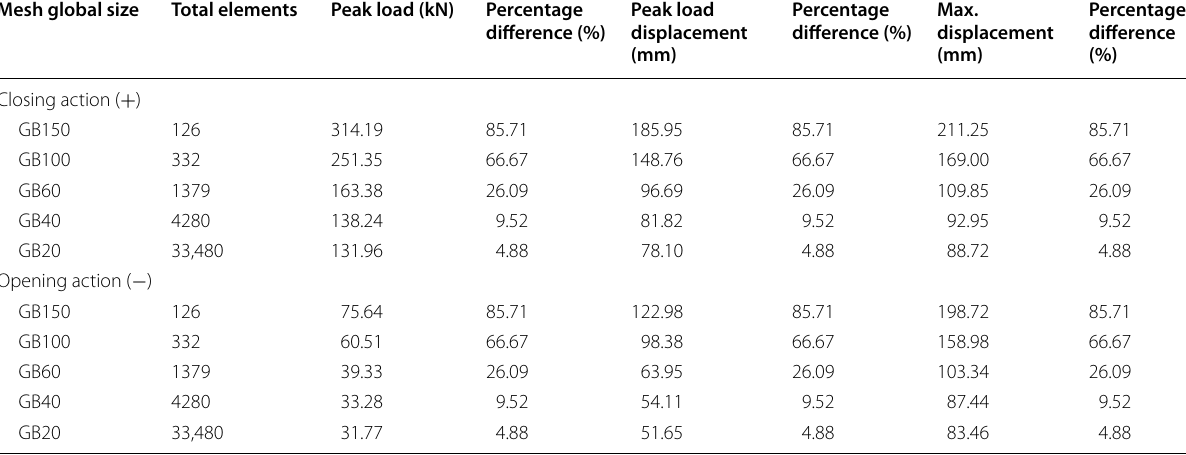
Table 6 Accuracy of mesh model against experimental data in closing and opening action Mesh global